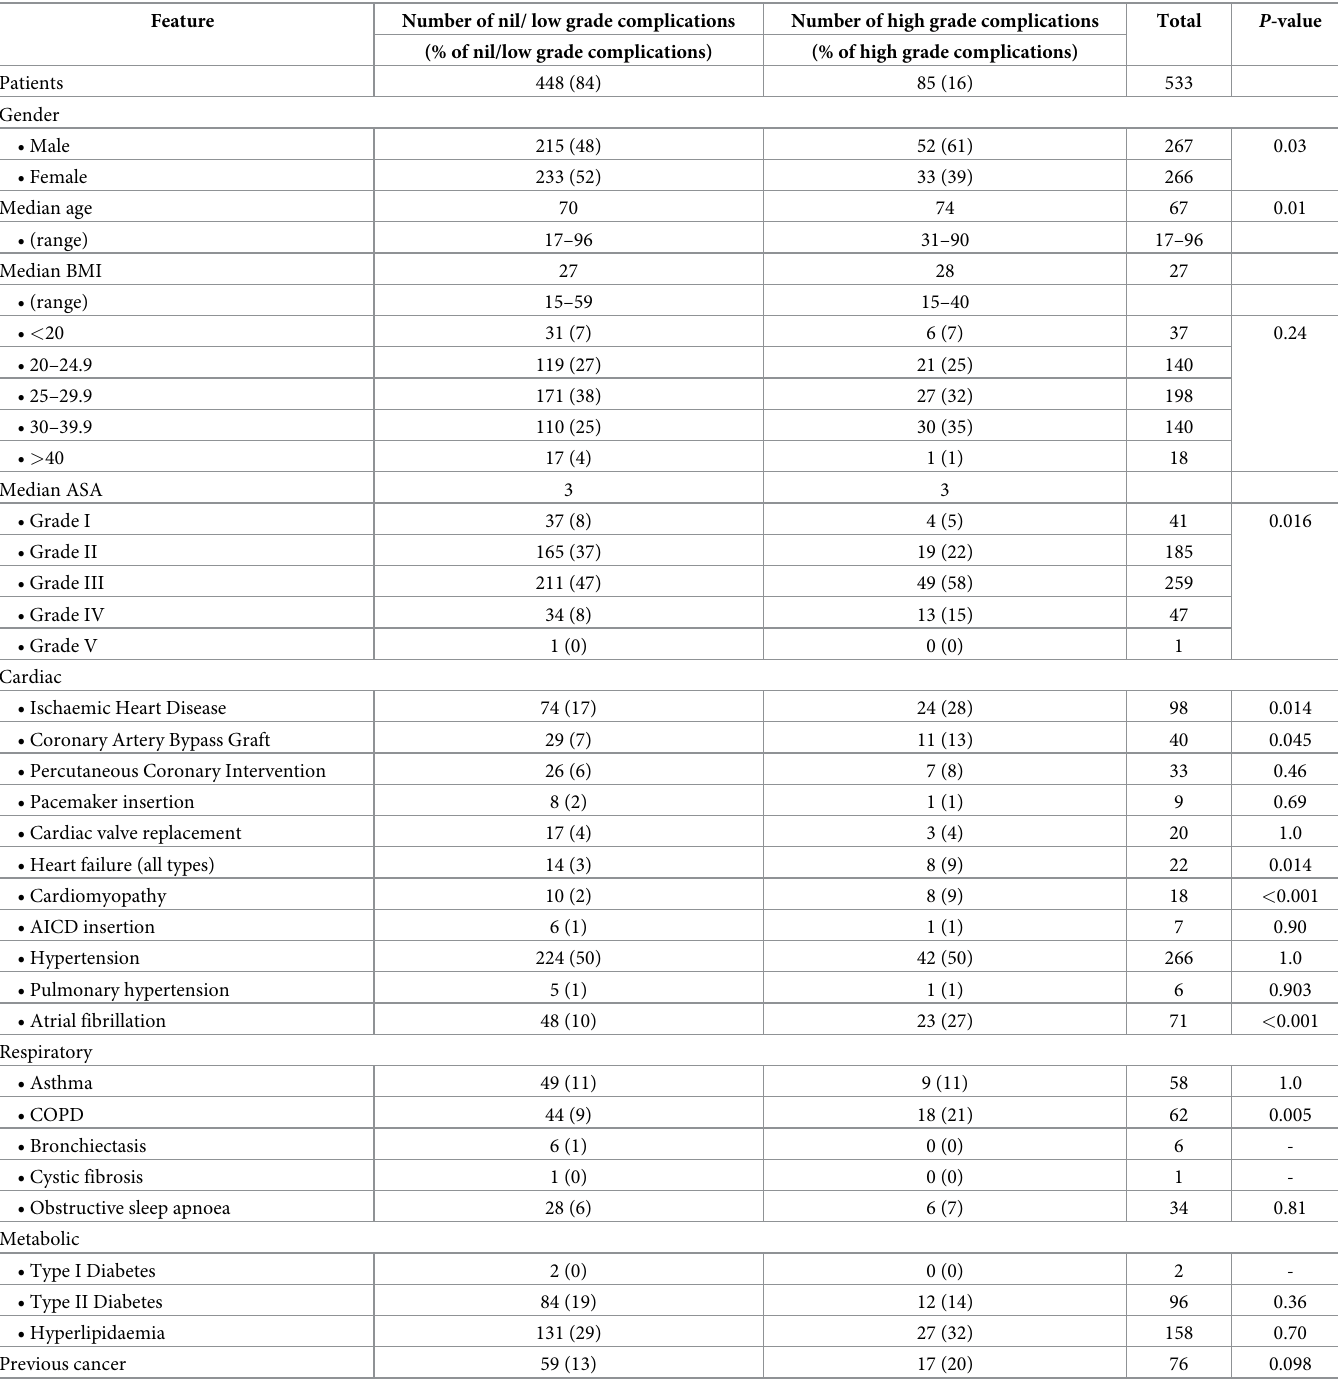
Table 1. Demographics and comorbidities of patients who underwent colorectal cancer resections at The Prince Charles Hospital between